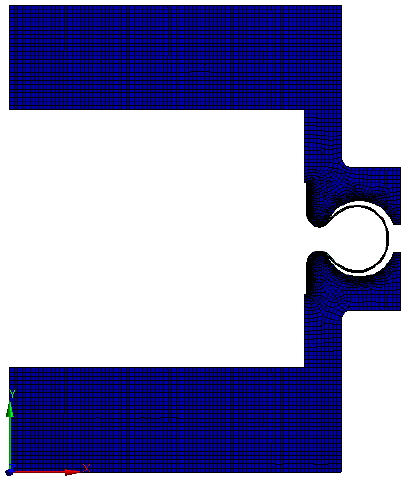
Figure 7. Shape of the bellows after hydroforming.